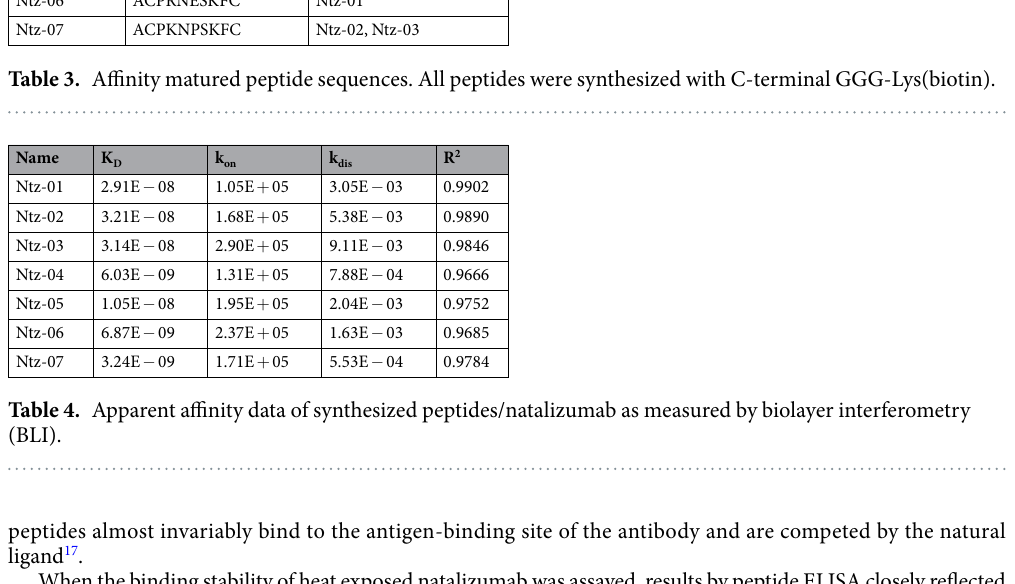
peptides almost invariably bind to the antigen-binding site of the antibody and are competed by the natural ligand 17 . When the binding stability of heat exposed natalizumab was assayed, results by peptide ELISA closely reflected the functional binding results obtained by cell-based assay. Conversely, the results by anti-Id ELISA showed no